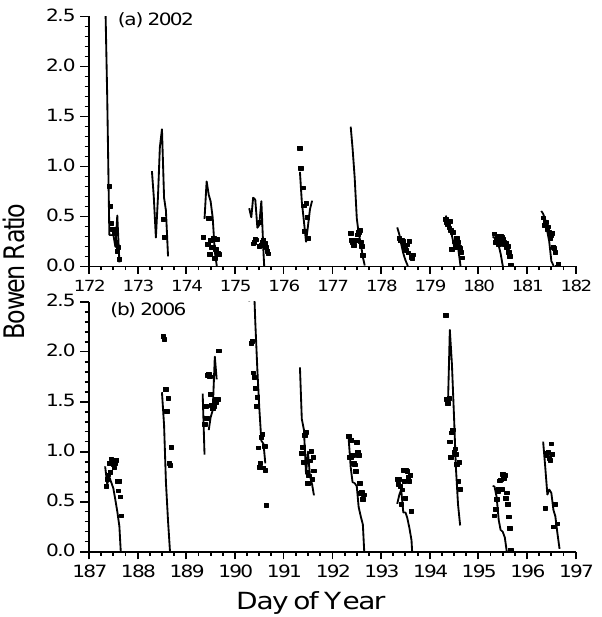
Fig. 6. Bowen Ratios measured (symbols) and modelled (lines) dur- ing warming events with high water table from DOY 173 to 182 in 2002 (0.2m in Fig. 2) and low water table from DOY 188 to 197 in 2006 (0.7m in Fig. 2) when net radiation > 250Wm − 2 .